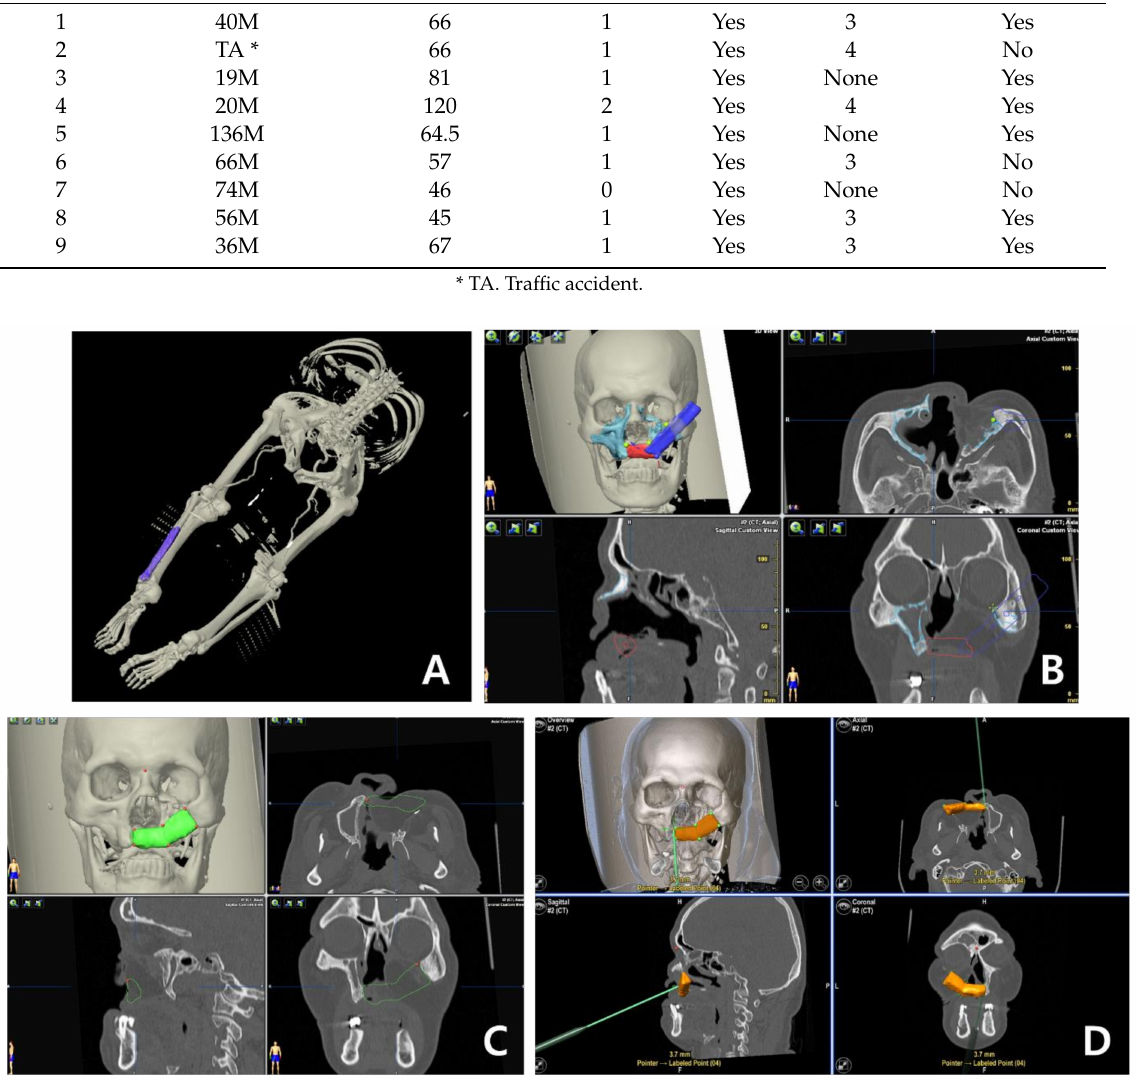
Figure 2. Preoperative procedure involving computer-aided design / computer-aided manufacturing (CAD / CAM) system with navigation system (BrainLab ® ) in order to enhance the accuracy and to reduce the operation time: ( A ) Lower extremity angio CT, ( B ) image export to the CAD program (BrainLab ® ), ( C ) the fibular bone is adjusted to the mirror image of contralateral side, and ( D ) navigation guide for the intraoperative